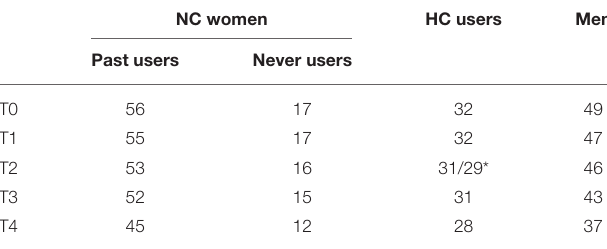
TABLE 1 | Distribution of participants at each time